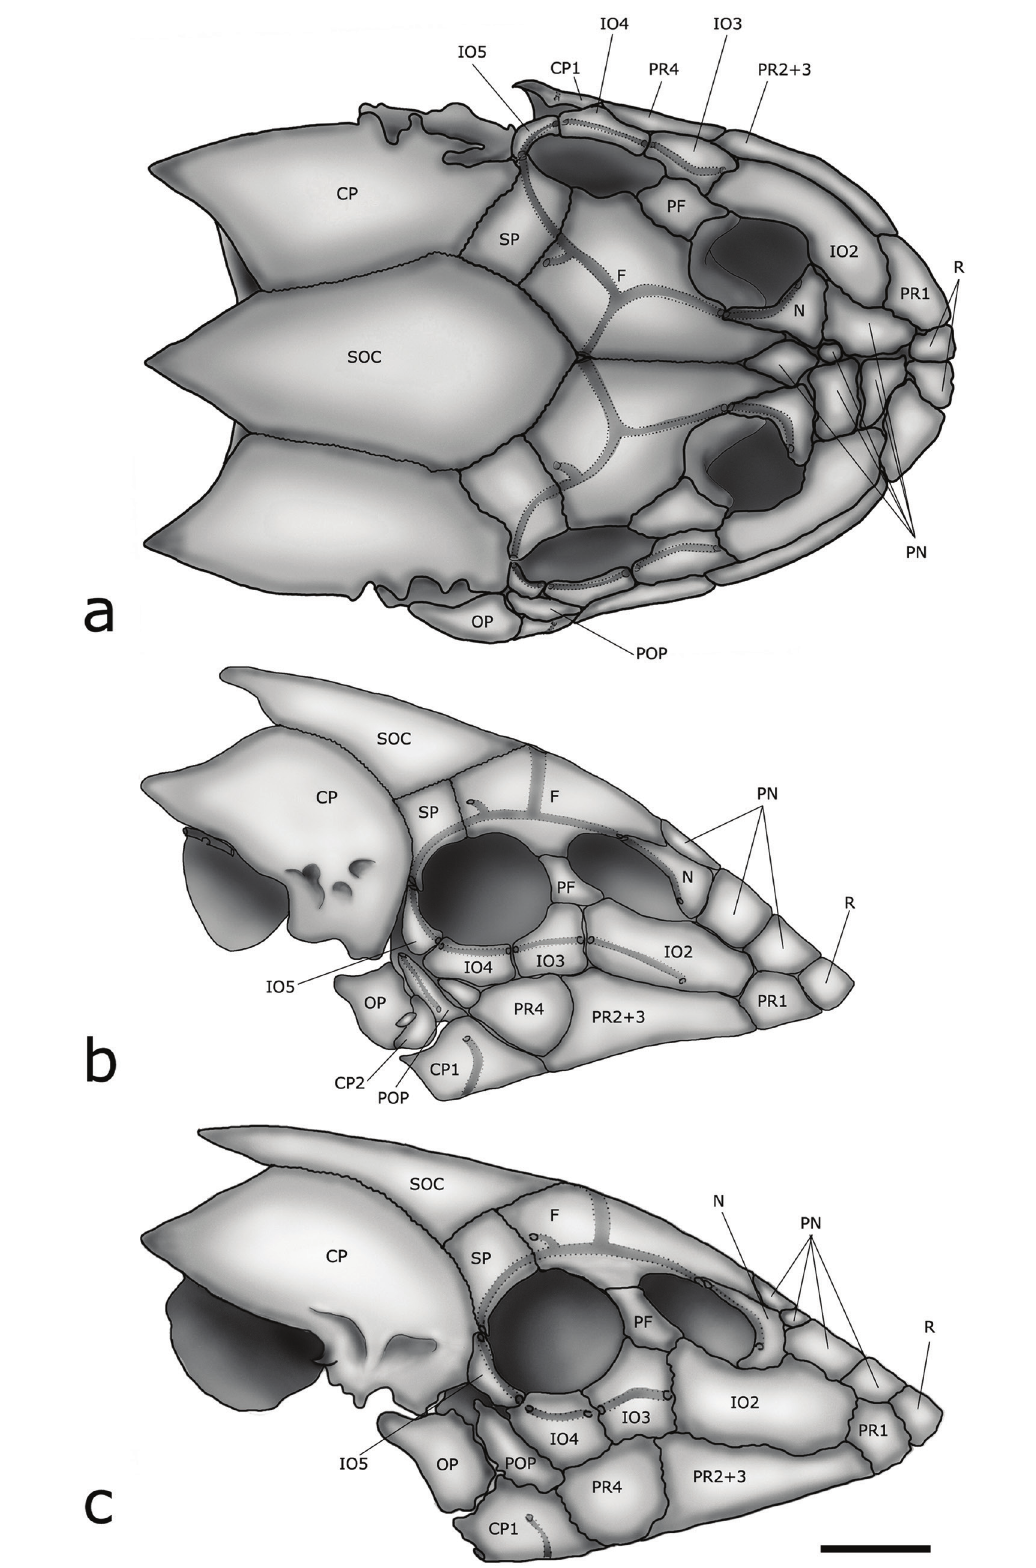
Fig. 1. Skull of Otothyris travassosi : a) MCP 36716, female, 27.5 mm SL (dorsal view). b) MCP 18100, female, 22.3 mm SL (right side). c) MCP 36716, female, 27.5 mm SL (right side). Abbreviations: CP, compound pterotic; CP1, canal-bearing plate 1; CP2, subocular cheek plate; F, frontal; IO2-5, infraorbitals 2-5; N, nasal; OP, opercle; PF, prefrontal plate; PN, pre-nasal plates; POP, preopercle; PR1-4, postrostral plates 1-4; R, rostral plate; SOC, supraoccipital; SP, sphenotic. Scale bar =